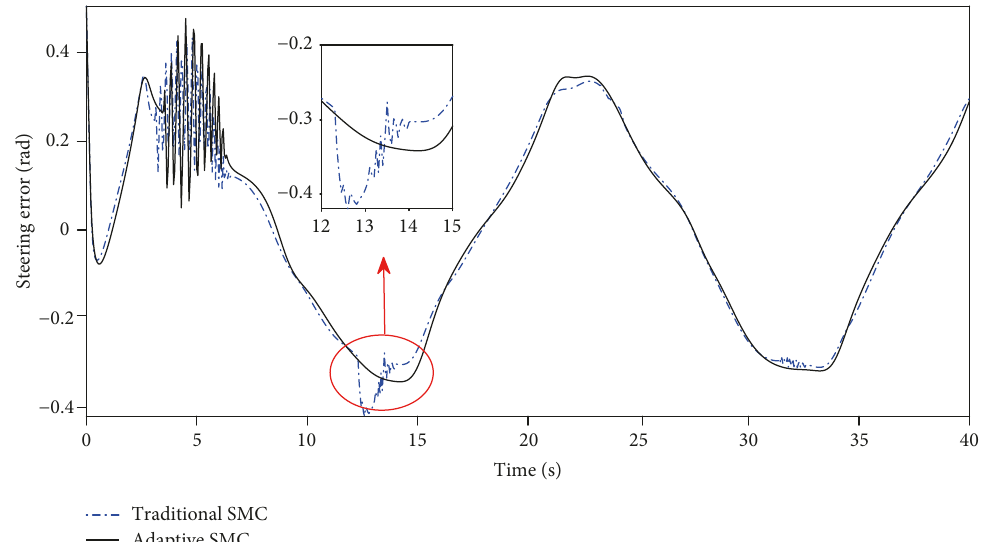
Figure 11: The comparison of errors in steering angle with SMCs.